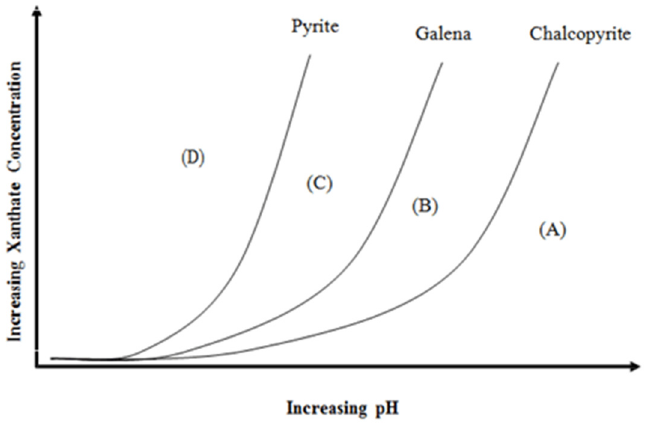
Figure 1. Critical pH change with increasing collector concentration for pyrite, galena and chalcopyrite (adapted from [5,6]) .